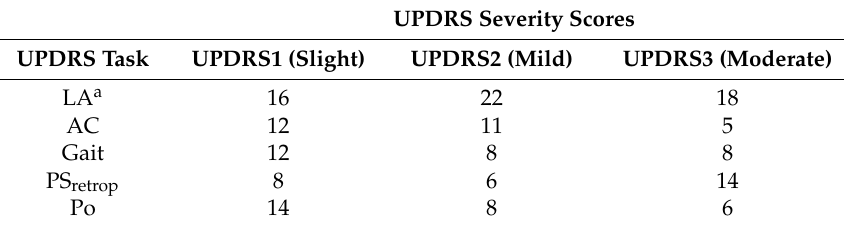
Table 3. Distribution of the severity scores among the UPDRS